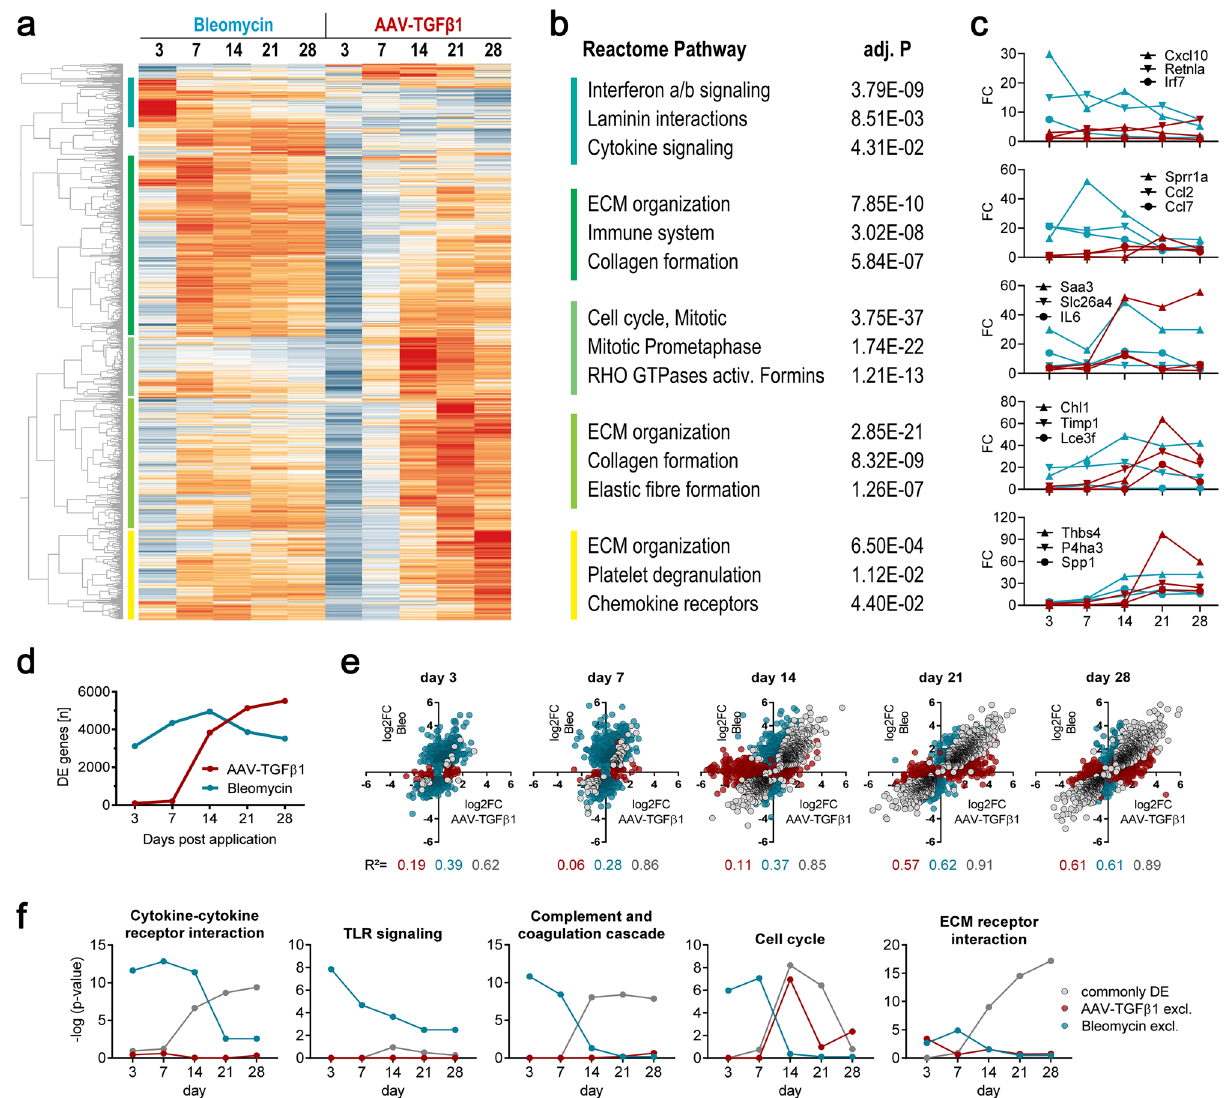
Figure 2. Longitudinal assessment of transcriptomic changes in AAV-TGFβ1 and Bleomycin induced fibrosis. Total RNA was extracted from the mice treated as described in Fig. 1 and applied to RNA-sequencing. ( a ) unsupervised hierarchical clustering (Z-scored FPKMs) of all mRNAs showing differential expression (log 2 FC ≥ 0.6, q ≤ 0.05) at ≥ two contrasts across all time points and models (n = 6010). The genes within the color-coded clusters were applied to ( b ) Reactome pathway enrichment analysis. Cluster 1, n = 148 genes; cluster 2, n = 552; cluster 3, n = 186, cluster 4, n = 403 and cluster 5, n = 275. ( c ) Expression profiles of the top 3 differentially expressed genes in each cluster. ( d ) Total number of differentially expressed genes over time for both models. ( e ) Correlation plots for genes showing differential expression either exclusively in one model or commonly in both models, as defined by expression cutoffs (log 2 FC = 0.6). The coefficient of determination (R 2 ) is show for each set of genes under the graphs. Legend as in ( f ). ( f ) Significance of enrichment ( p -value) for selected KEGG pathways over time, obtained and plotted for the gene sets defined in ( e ). TLR = toll-like receptor. ECM = extracellular matrix. Heatmap created with TIBCO Spotfire Analyst 3, 7, 14, 21 and 28 after administration and analyzed by RNA-sequencing. The number of differentially expressed (|log 2 FC|≥ 0.6, adjusted p-value ≤ 0.05) genes over time (Fig. 2d), unsupervised hierarchical clustering (Fig. 2a) and correlation of model-specific or commonly deregulated genes (Fig. 2e) nicely mirrored the chronology of phenotypic disease manifestation, i.e., specific effects early on day 3 in the Bleomycin model, which are absent in the AAV model, as well as greater similarity between the models during the fibrotic phase (day 14–28), par- ticularly on day 21. A list of the top 20 up-regulated genes per time point is available in the supplement (Suppl. Table 1). Moreover, also a very similar induction of collagen genes was observed across models over time, with a faster onset again observed in the Bleomycin model but a tendency towards slightly higher induction of the highly abundant collagens in the AAV model (Suppl. Fig. 3). These data underscore our finding of a similar overall degree of fibrosis development, as also suggested by the phenotypic data in Fig. 1.